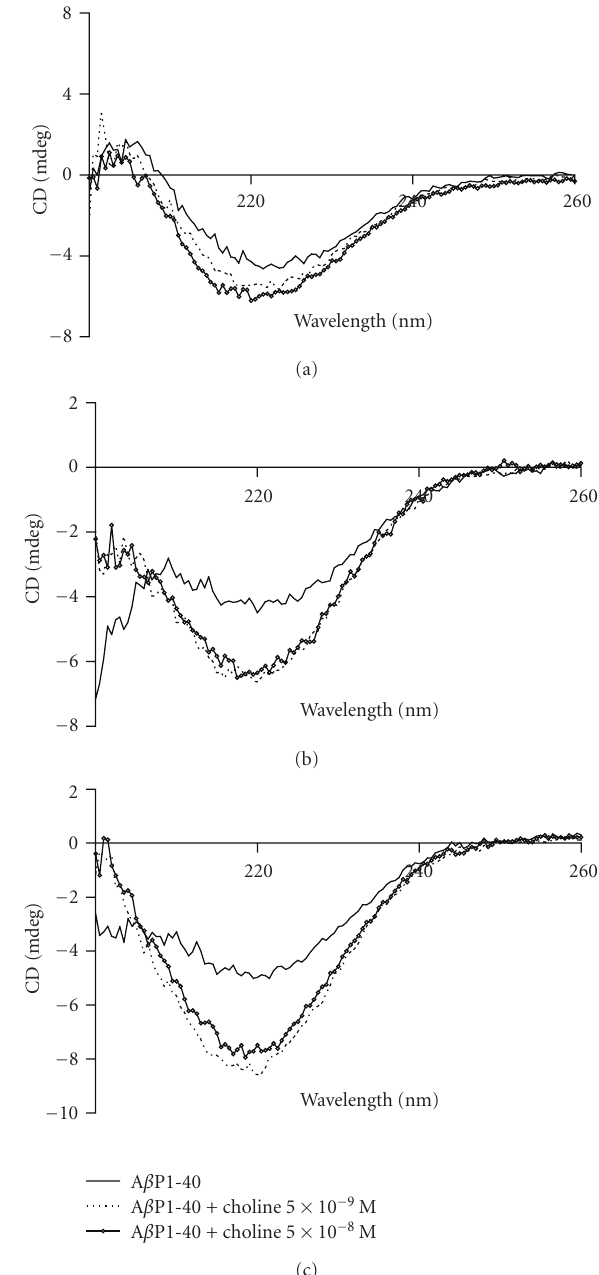
Figure 9: A β P1-40 secondary structure. Far-UV CD spectroscopy of A β P1-40 (5 × 10 − 6 M) in the absence and in the presence of choline (5.77 × 10 − 8 M; 5.77 × 10 − 9 M) after 5 minutes (a), 24 hours (b) and 48 hours (c) of incubation. See text for experimental